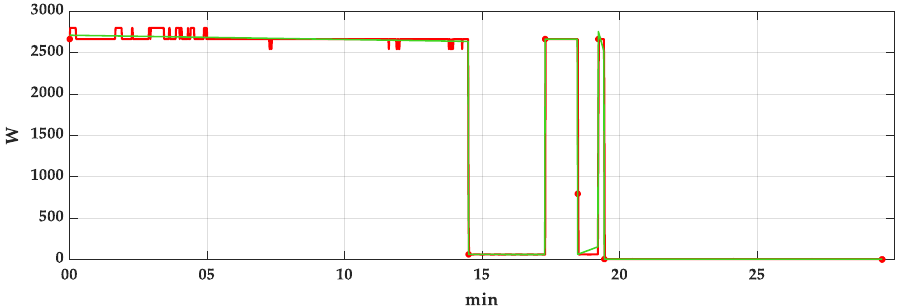
Figure 22. PWL approximation of the oven load profile — RMS value 110.9 (measured data — red vs. approximated profile — green).